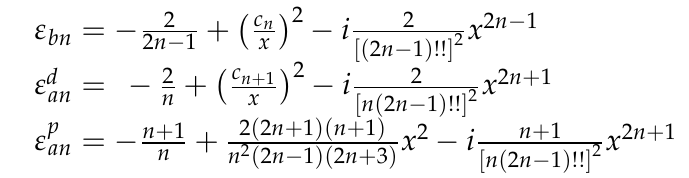
Table 1. Rules of the resonances on a homogeneous sphere for n = 1,2,3,....